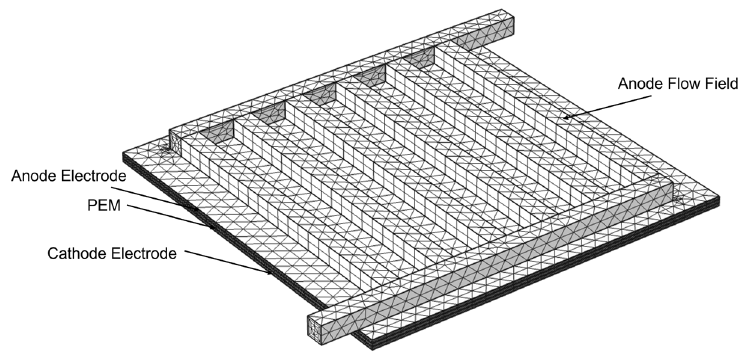
Figure 2. The computational domain of the